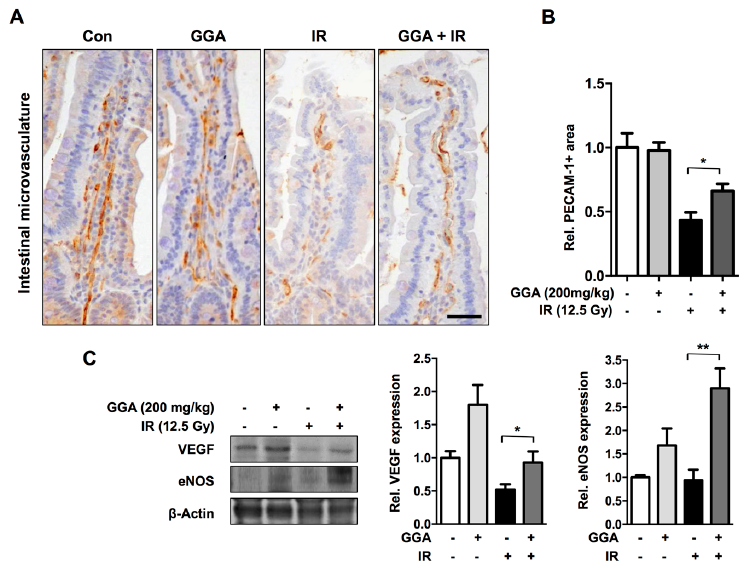
Figure 2. The effect of GGA on mouse intestinal endothelial cells following IR. ( A ) Representative images of intestinal microvessels in mice following GGA and IR treatment. Immunohistochemical staining for PECAM-1, a pan-endothelial cell marker, was performed on intestinal tissue (brown). Scale bar = 20 µm; ( B ) Quantification of PECAM-1 expression. PECAM1 expression was measured and quantified in the villi and lamina propria of the 10 longest villi in four slices from each animal; ( C ) Representative western blotting for VEGF and eNOS using intestine tissues and the quantification. The data are presented as the mean ± SEM; n = 6, * p < 0.05, ** p < 0.01.